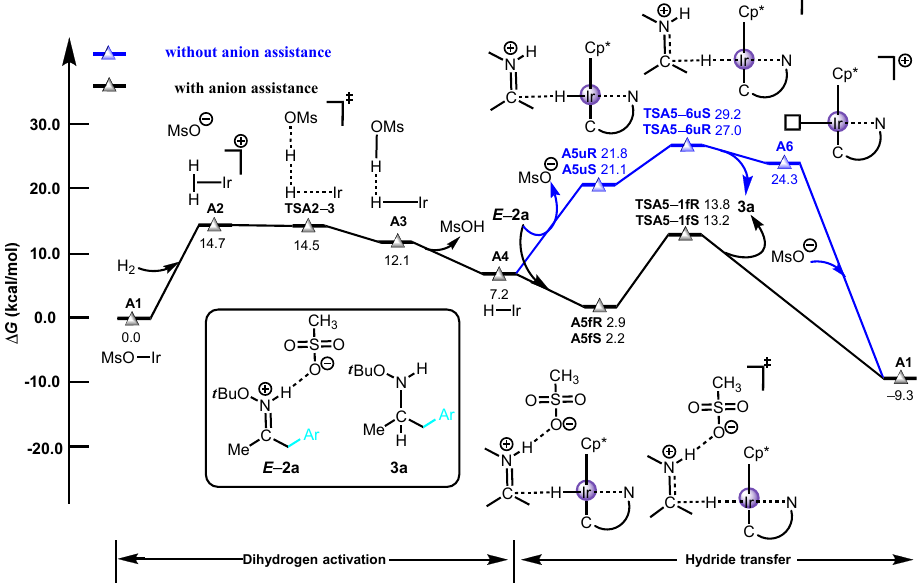
Figure 1. The Gibbs free energy profiles of asymmetric hydrogenation of oximes to hydroxylamines catalyzed by Ir complex A1 (unit: kcal/mol). * represents chirality and ‡ means this is a transition state.